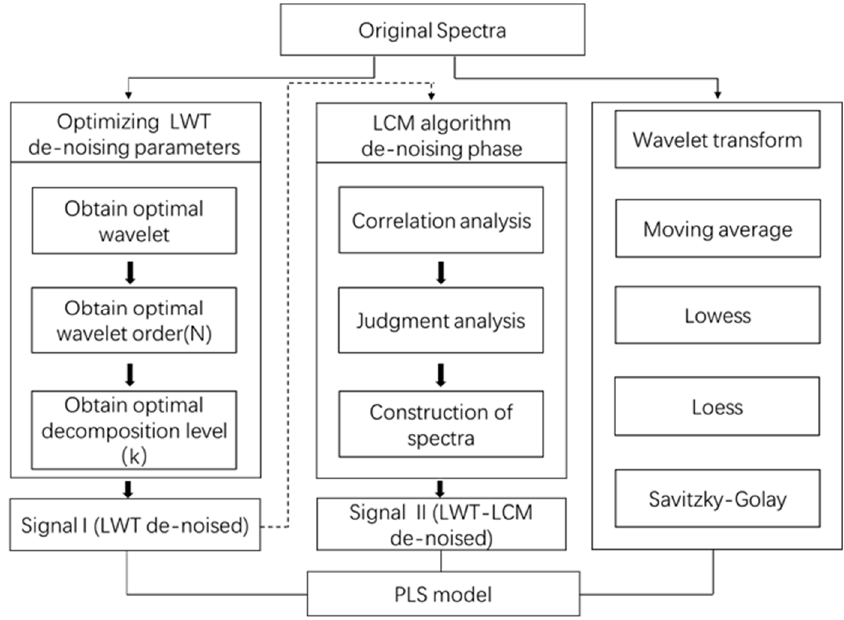
Figure 2. An overview of steps in Vis-NIR spectra processing.